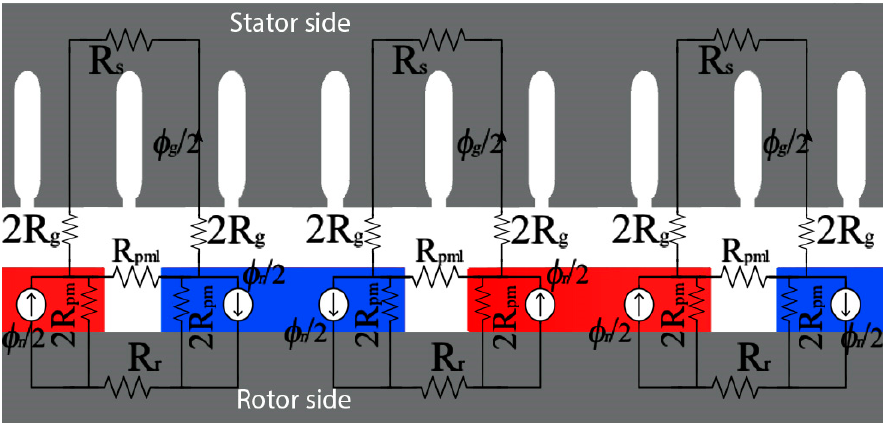
Figure 3. MAGEC design of the studied single air gap, slotted AFPM machine.